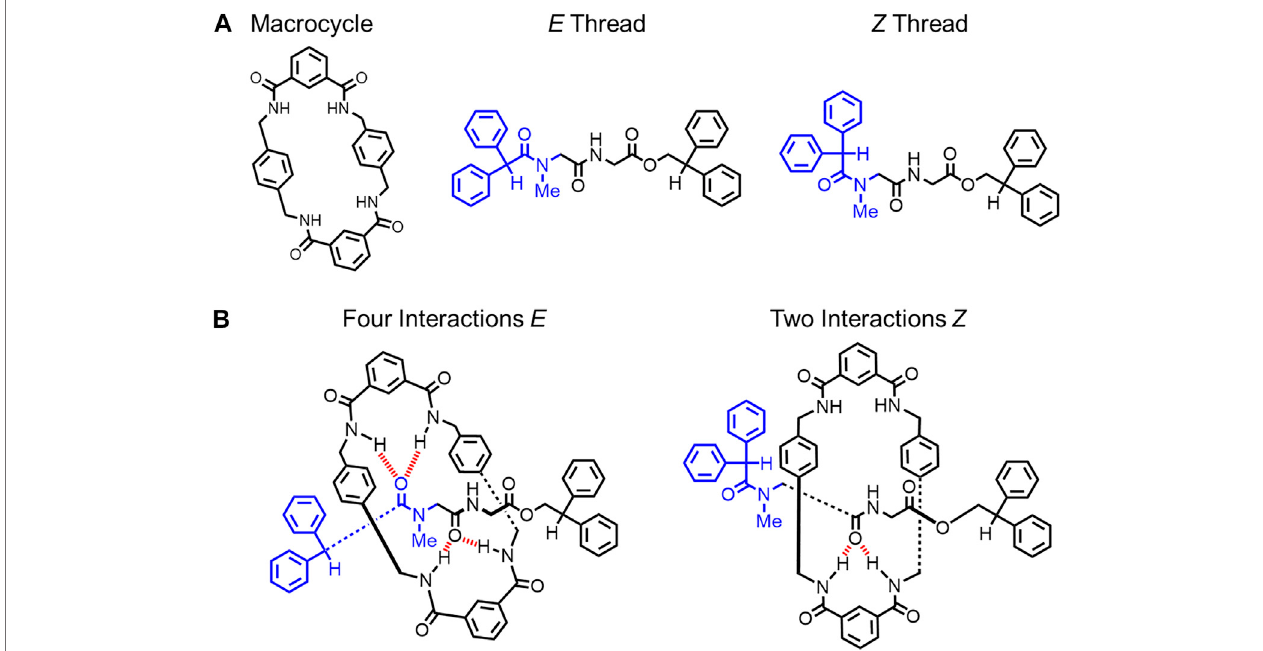
FIGURE 7 | (A) Macrocycle structure, thread conformations and (B) hydrogen-bond interactions in the two rotaxane architectures.